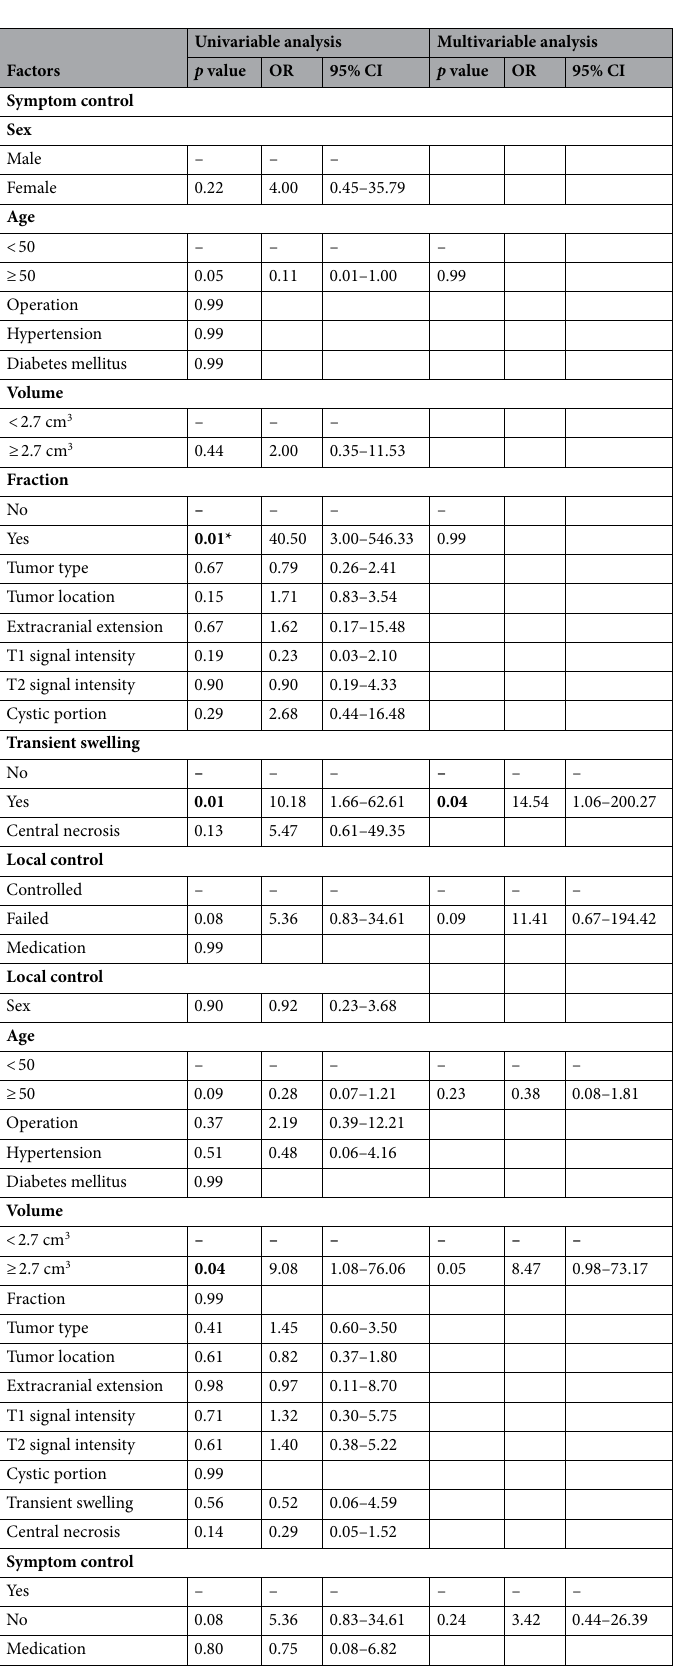
Table 2. Results of univariable and multivariable analyses of symptom control and local control. *Bold p values are statistically